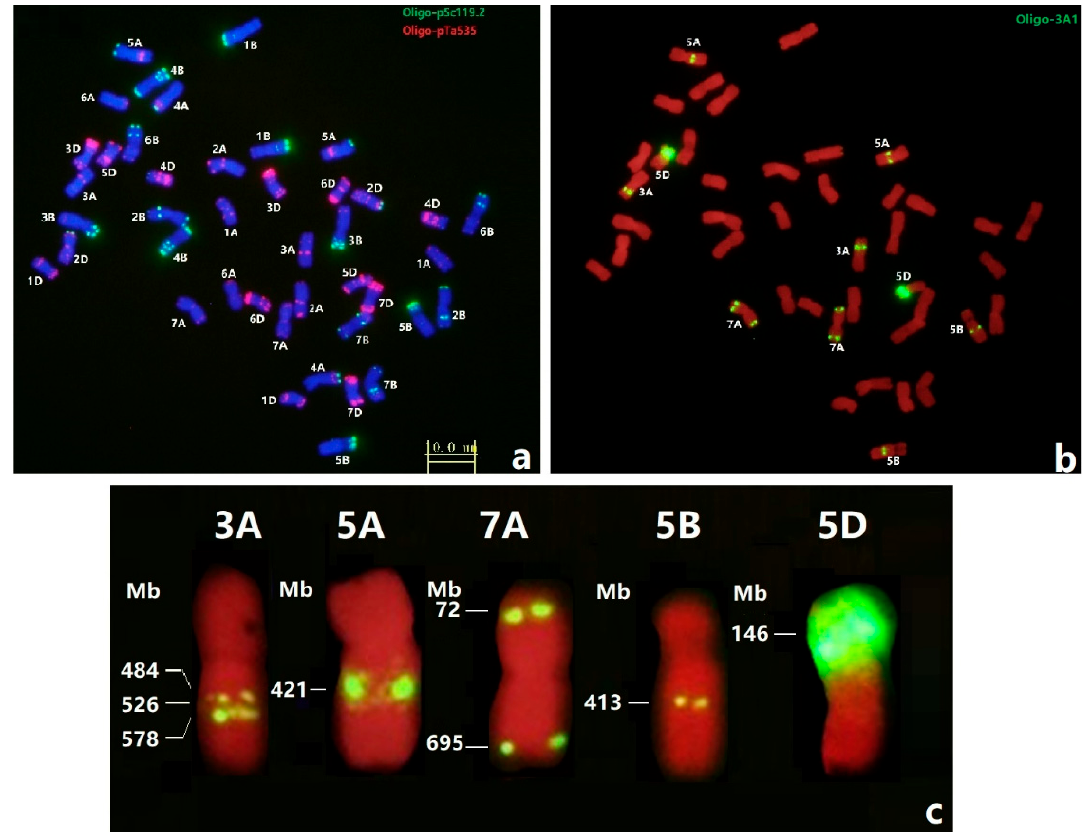
Figure 4. Nondenaturing fluorescence in situ hybridization (ND-FISH) patterns of Ta-3A1 repeats in wheat Chinese Spring: The probes Oligo-pSc119.2 (green) and pTa535 (red) ( a ), and sequential Oligo-3A1 (green) ( b ), were used for ND-FISH. The copy numbers predicted by web server page B2DSC and the copy number of Ta-3A1 at the specific region of each 1-Mb scale were illustrated in karyotypes of chromosomes ( c ). Bar indicated 10 μ m.